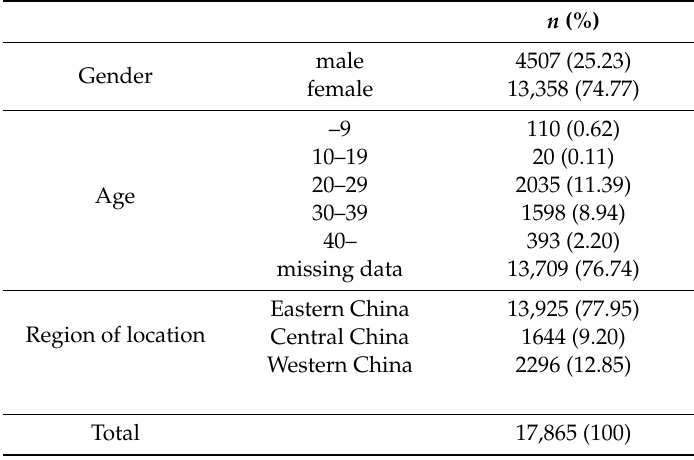
Table 1. Demographic characteristics of selected participants.